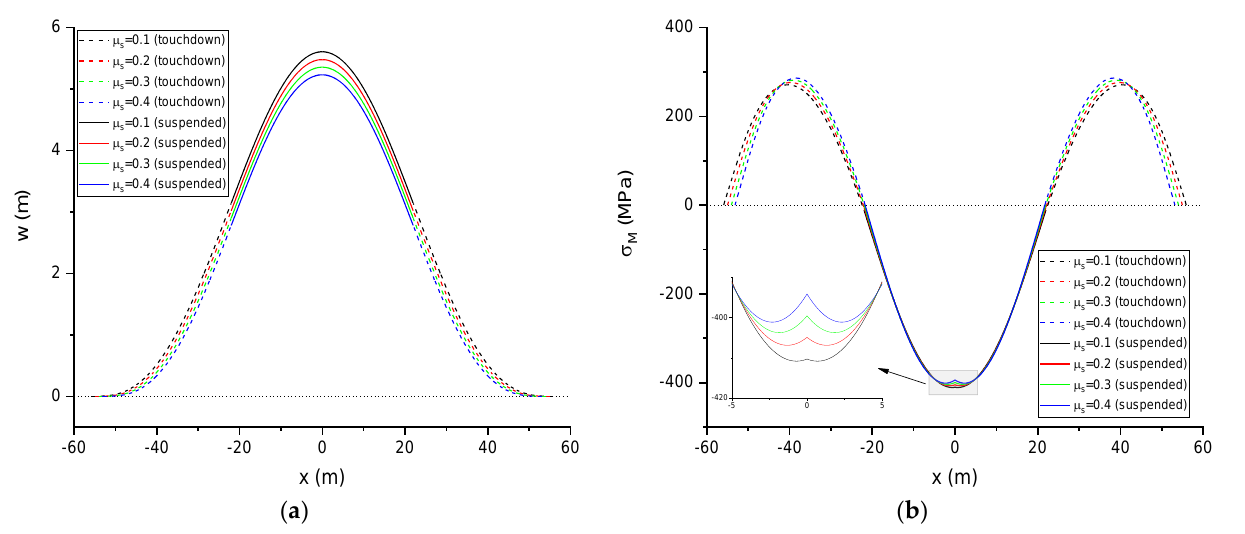
Figure 13. Influence of 𝜇 𝑠 on configurations. ( a ) Deformed shapes. ( b ) Bending stresses ( 𝜇 𝑏𝑟𝑘 = 2.0 , Figure 13. v om on configurations. ( a ) Deformed shapes. ( b ) Bending stresses ( µ brk = 2.0, v om = 0.1 m, 𝑣 𝑜𝑚 = 0.1 m, 𝑇 0 = 40 °C ). T 0 = 40 ◦